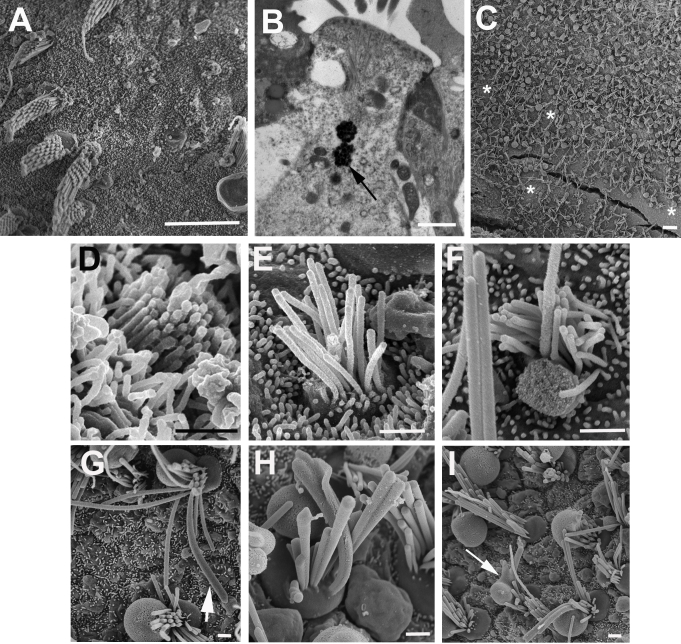
Mouse utricular maculae. (A) A 22-month-old CBA/Ca mouse. Stereocilia of hair bundles in orderly arrays. Hair cells missing over a large area where supporting cells have closed the lesions. (B) A 24-month-old CBA/Ca mouse. Longitudinal section of hair cell with granules (arrow) of an appearance consistent with lipofuscin. (C) A 24-month-old CBA/Ca mouse. The macula is covered with hair cells, but there are many regions where hair cells are missing (asterisks) throughout the tissue. (D–F) Immature bundles. (D) Immature hair bundle in early postnatal (P4) C57Bl/6 mouse. Stereocilia are of equal height and cross-linked. (E, F) Immature-appearing hair bundles in old mice: 24-month-old CBA/Ca. (G–I) Stereocilia anomalies in old (24 months) CBA/Ca mice. (G) Giant, fused stereocilia (arrow). (H) Multiple fusions and swellings along shaft and at tip. (I) Fusion and enlarged swelling (arrow). Scale bars: (A) 10 μm; (B) 1 μm; (C) 10 μm; (D–I) 1 μm.